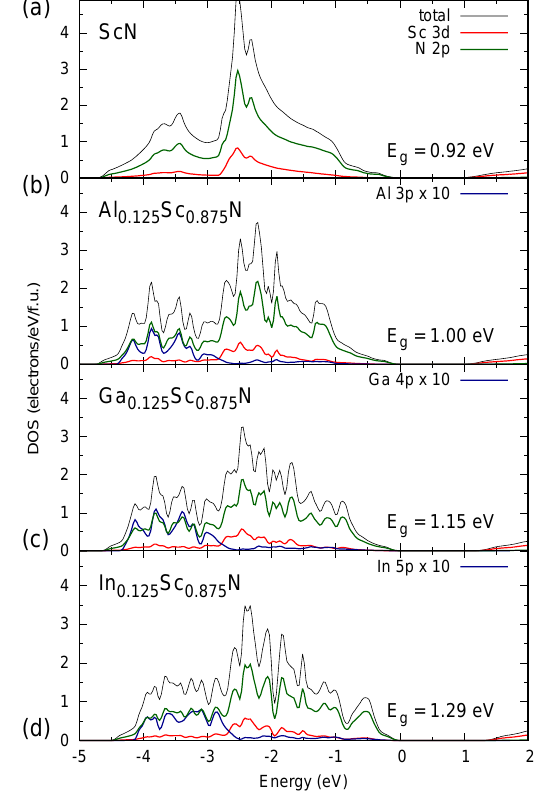
Figure 3. Density of states calculated (MBJLDA) for rock salt alloys ( a ) ScN, ( b ) Al 0.125 Sc 0.875 N, ( c ) Ga 0.125 Sc 0.875 N, and ( d ) In 0.125 Sc 0.875 N. Please note that the p -type contributions of group III ions are magnified by 10.